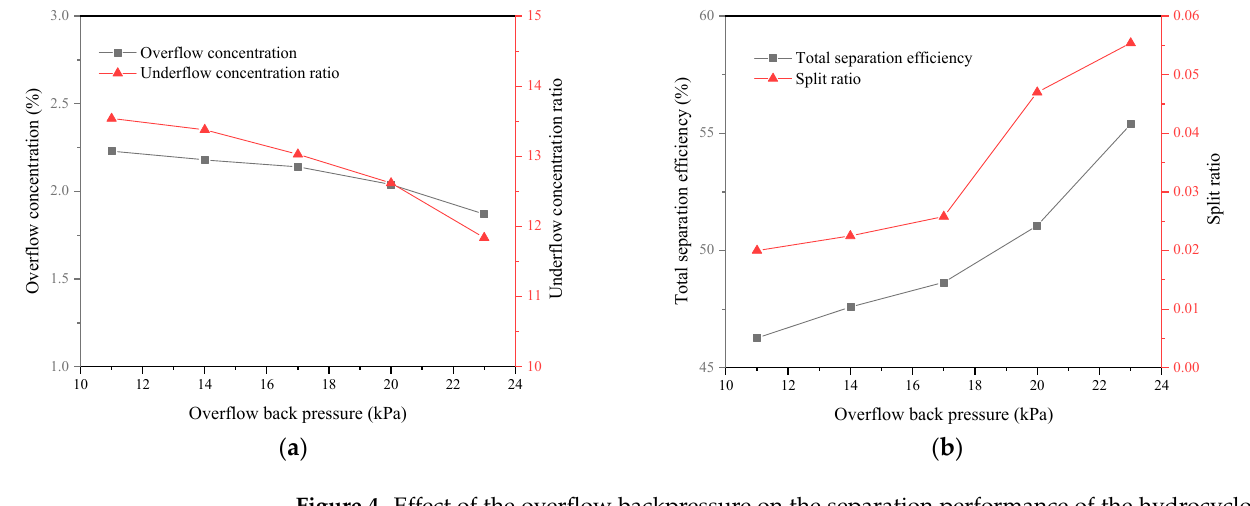
Figure 4. Effect of the overflow backpressure on the separation performance of the hydrocyclone. ( a ) Product concentration. ( b ) Product distribution. Table 4. Effect of the overflow backpressure on the classification performance of the hydrocyclone. Content of − 45 µ m Particles Overflow Backpressure (kPa)